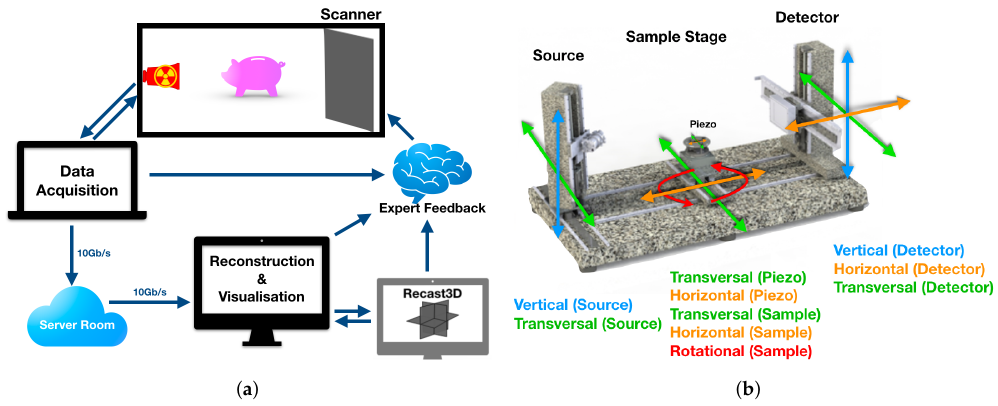
Figure 2. The FleX-ray Laboratory setup sketched in detail in ( a ), and the scanner motors within the FleX-ray scanner shown in ( b